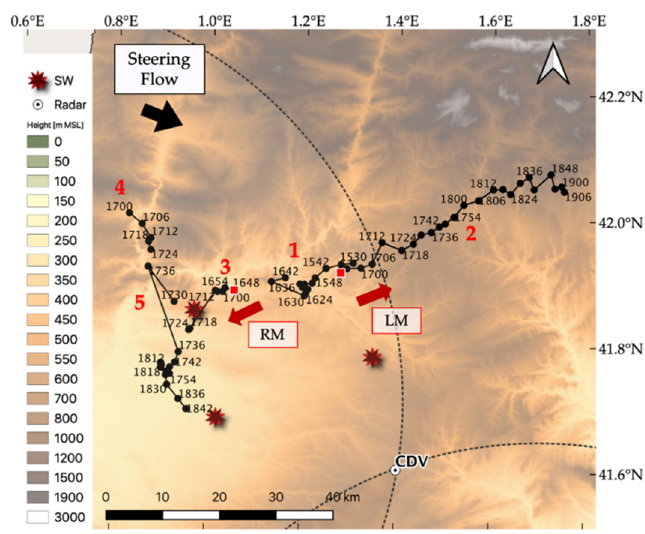
Figure 10. Track of the splitting storm 10 July 2013 over topography. Part of the 30° CDV-LMI pair dual-lobes is depicted in dotted lines. Red stars indicate Severe Weather (SW) occurrences (wind gusts and hail). Red numbers indicate the different cells that took place in the system identified by [43], being 1 (primary cell), 2 (left mover), and 3 (right mover), the ones of interest taking part in the splitting process. Red squares indicate the starting point of the left (cell 2) and right (cell 3) movers, and red arrows indicate their motion. The black arrow indicates the mean NW steering flow at 3 km (direction of motion for the majority of the cells during that day). Dots indicate the different cell centroid times labeled in UTC.